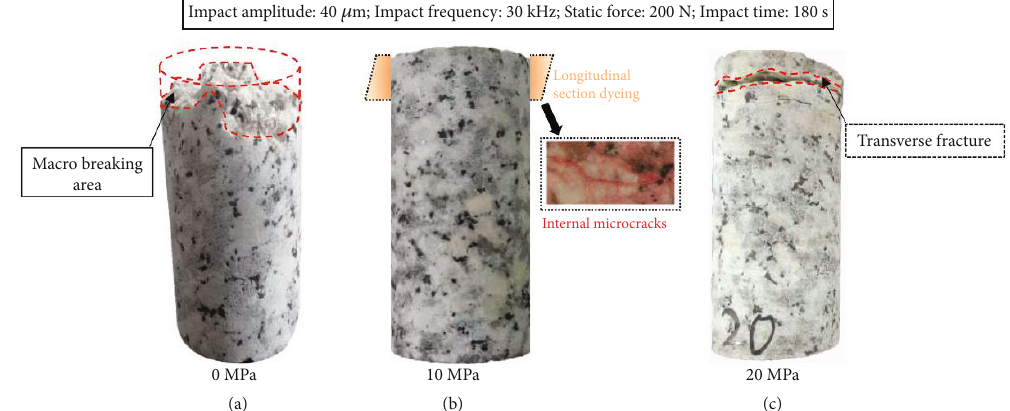
Figure 8: Granite failure modes under UHF impact subjected to con fi ning pressure: (a) con fi ning pressure of 0MPa; (b) con fi ning pressure of 10 MPa; (c) con fi ning pressure of 20 MPa.